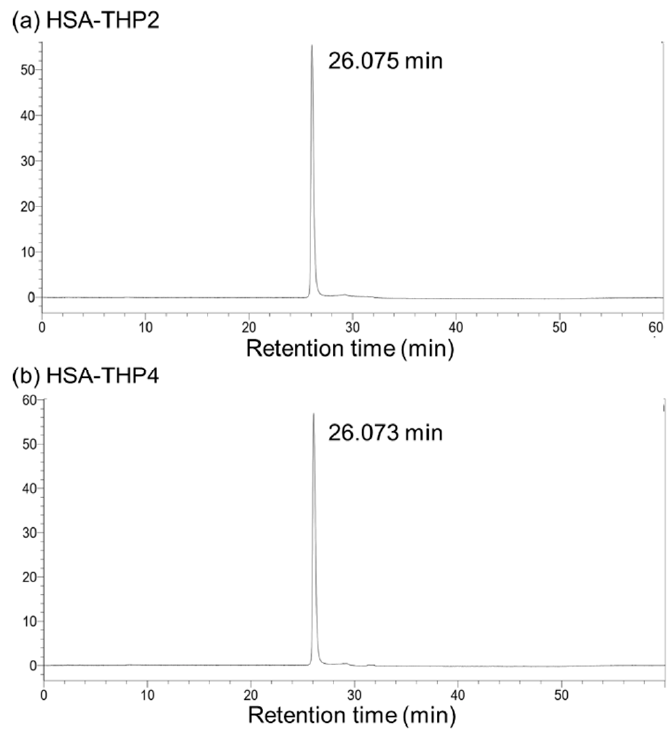
Figure 4. HPLC analyses of ( a ) HSA-THP2 and ( b ) HSA-THP4. HPLC was performed on a Shimadzu HPLC system equipped with an RF-10AXL fluorescence detector (excitation at 488 nm, emission at 590 nm). See text for detail.